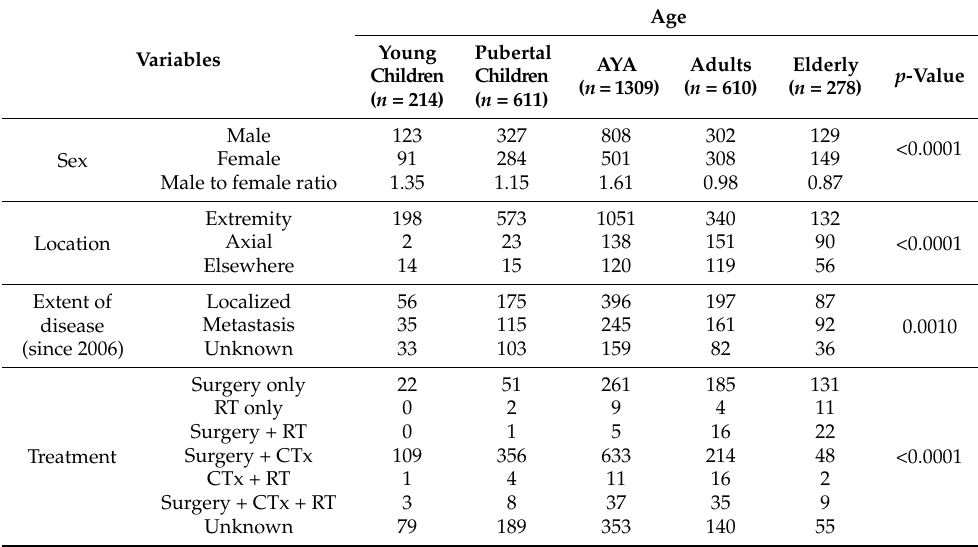
Table 2. Comparison of clinical characteristics between the age groups.